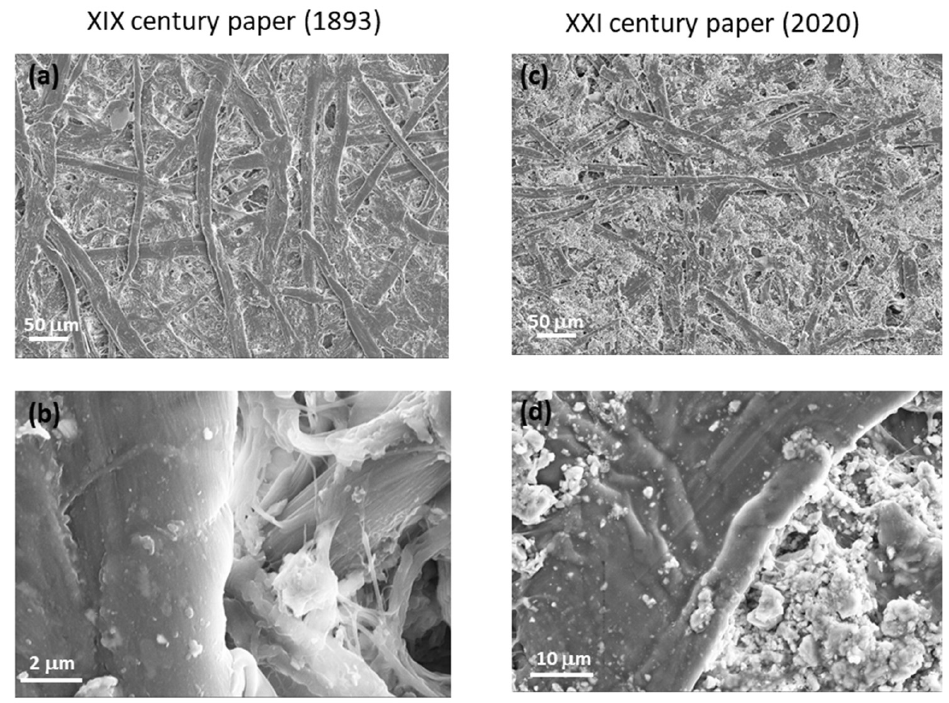
Figure 6. HR-SEM images of two paper samples of ( a , b ) XIX and ( c , d ) XXI century at different mag- nifications.